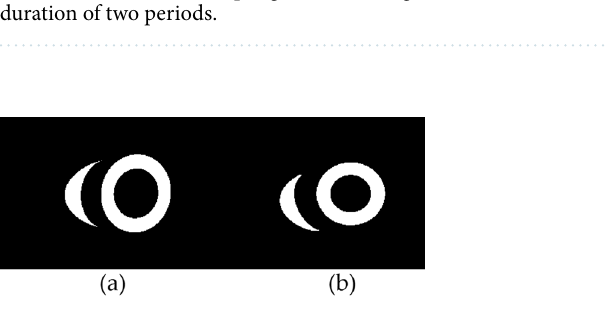
Table 9. Parameter signals used to construct the numerical phantom. f h = 2 Hz is the fundamental frequency and T s = 20 ms is the sampling time of the signals, where t = nT s with n = [0, 1 · · · , 49] . Corresponding to a duration of two periods.